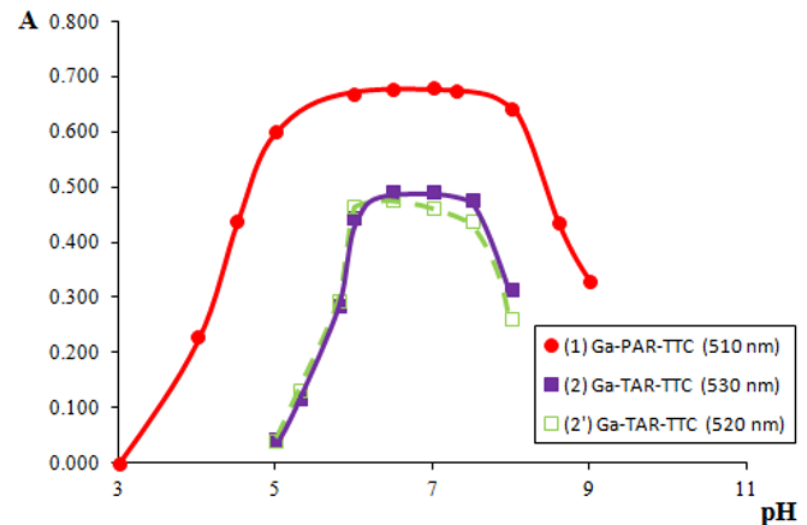
Figure 2. Absorbance of Ga(III)-ADR-TTC complexes in chloroform vs. pH of the aqueous phase plots.